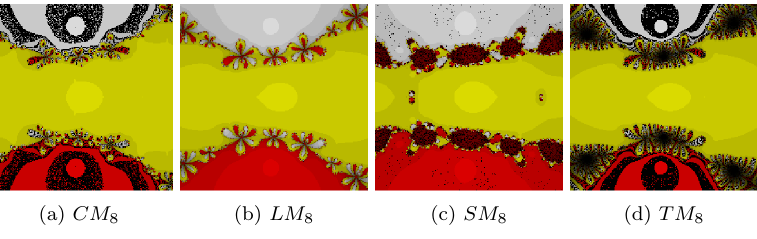
Figure 3. The methods for test problem 2.